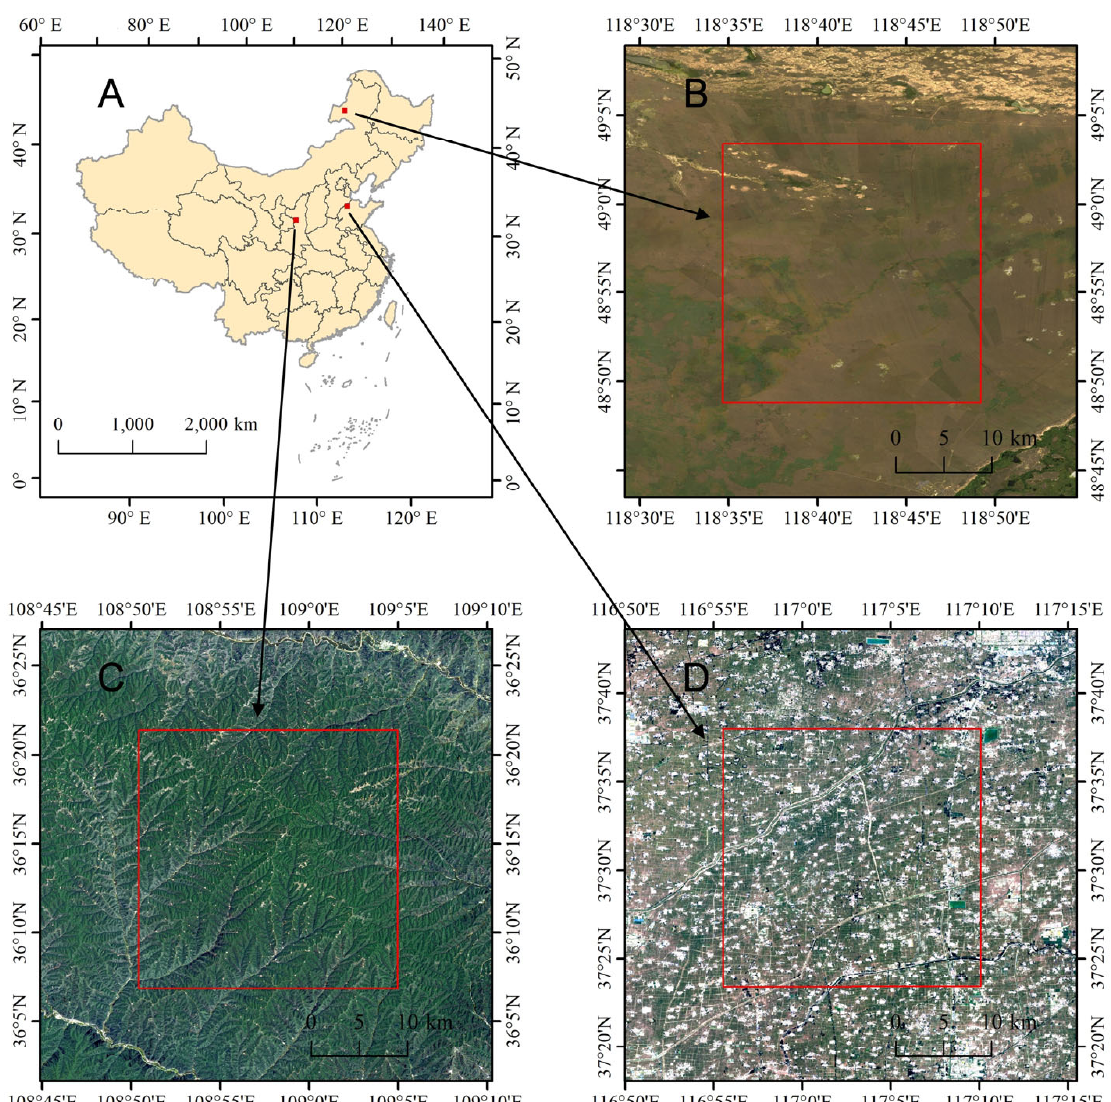
Figure 1. Location and surface cover of the test areas. ( A ), location of the three test areas in China. ( B ), grassland test area, located in the temperate continental grasslands of northern China. ( C ), forest test area, located in the hilly gully zone of the Loess Plateau in Northern Shaanxi. ( D ), farmland test area, located in the lower alluvial plain of the Yellow River. For the fusion experiments in different test areas and different models, we used MODIS NDVI data of the intermediate date as the coarse-resolution image input for the prediction date, and Landsat NDVI data of the corresponding date as the reference image to verify the fusion results. In addition, as STARFM and FSDAF only require a pair of base period images, we selected the data closest to the prediction date, i.e.,: in the grassland test area, LC09_124026_20220520 (Figure 2A) and MOD09Q1/2022_05_17 (Figure 2D) were used; in the forest test area, LC09_127035_20220728 (Figure 2I) and MOD09Q1/2022_07_28 (Figure 2L) were used; in the farmland test area, LC09_122034_20220607 (Figure 2O) and MOD09Q1/2022_06_02 (Figure 2R) were